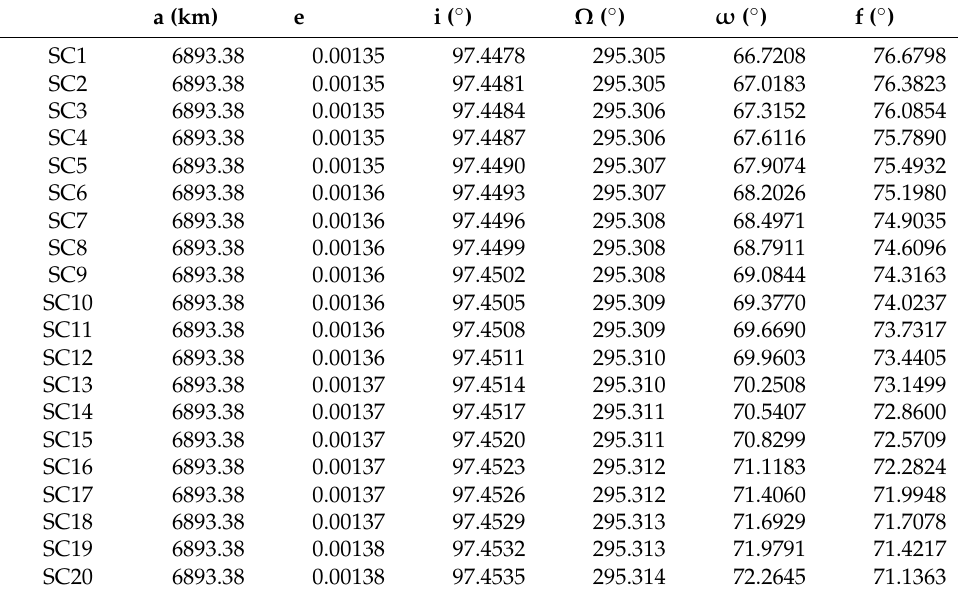
Table 1. Initial elements from the nominal spacecraft.